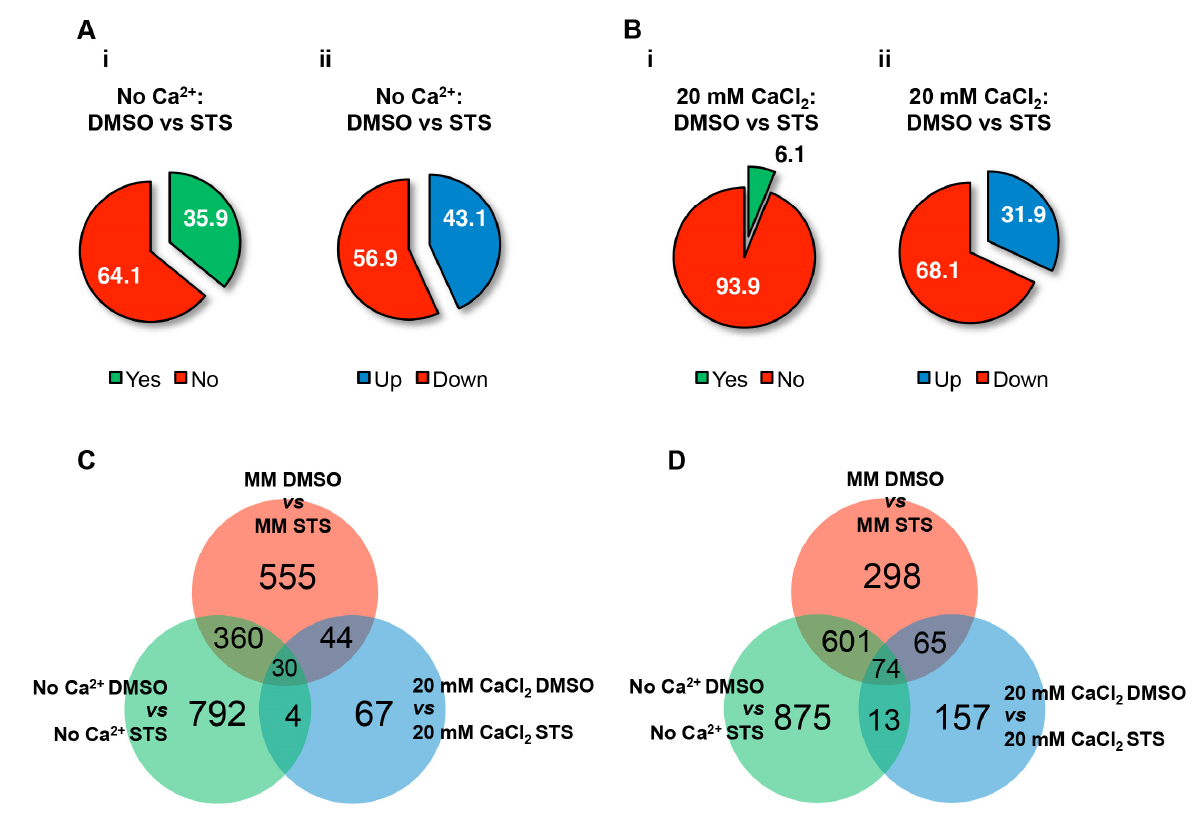
FIGURE 3: Overview of the N. crassa transcriptional response to staurosporine in minimal media containing different concentrations of Ca 2+ . (A-B) The percentages of genes with altered expression upon treatment with staurosporine (i) and the fraction of induced and re- pressed genes (ii) were calculated for culture medium with no Ca 2+ (A) or with 20 mM CaCl 2 (B) . (C-D) Venn diagrams were used to assess the amount of Ca 2+ -specific staurosporine-induced (C) and -repressed genes (D) . General statistics for Ca 2+ -specific transcriptional responses are